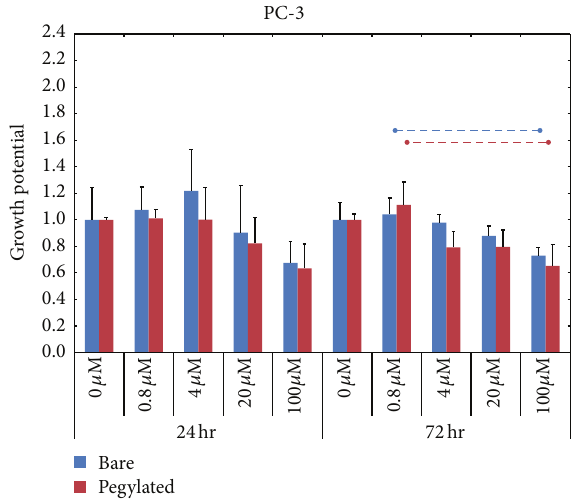
Figure 4: PNT1A cell proliferation after treatment with bare and pegylated PHAuNPs for 24 and 72 hours. All the values depicted have been normalized to the non treated control (0 𝜇 M). After 72 hours of treatment, there was a significant decrease in the proliferation of cells treated with 100 𝜇 M bare nanoparticles. The horizontal bars indicate that there is a significant difference at 𝑃 ≤ 5 %.